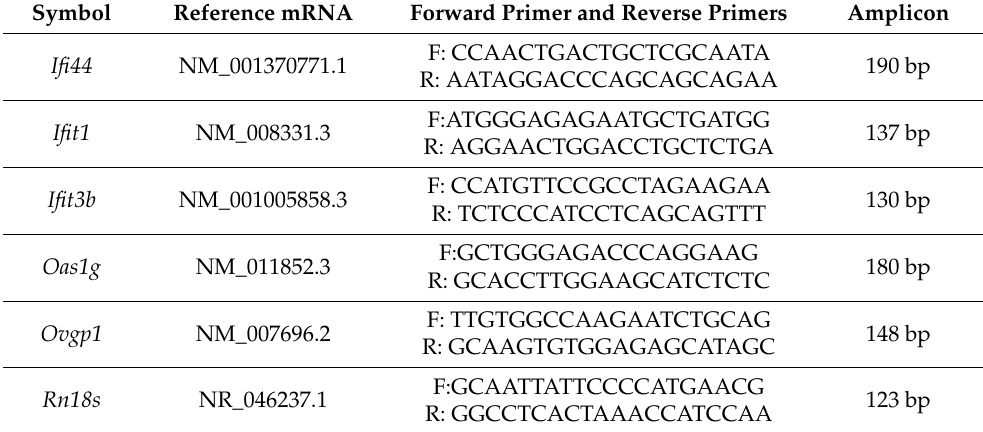
Table 1. List of primers used in the qPCR